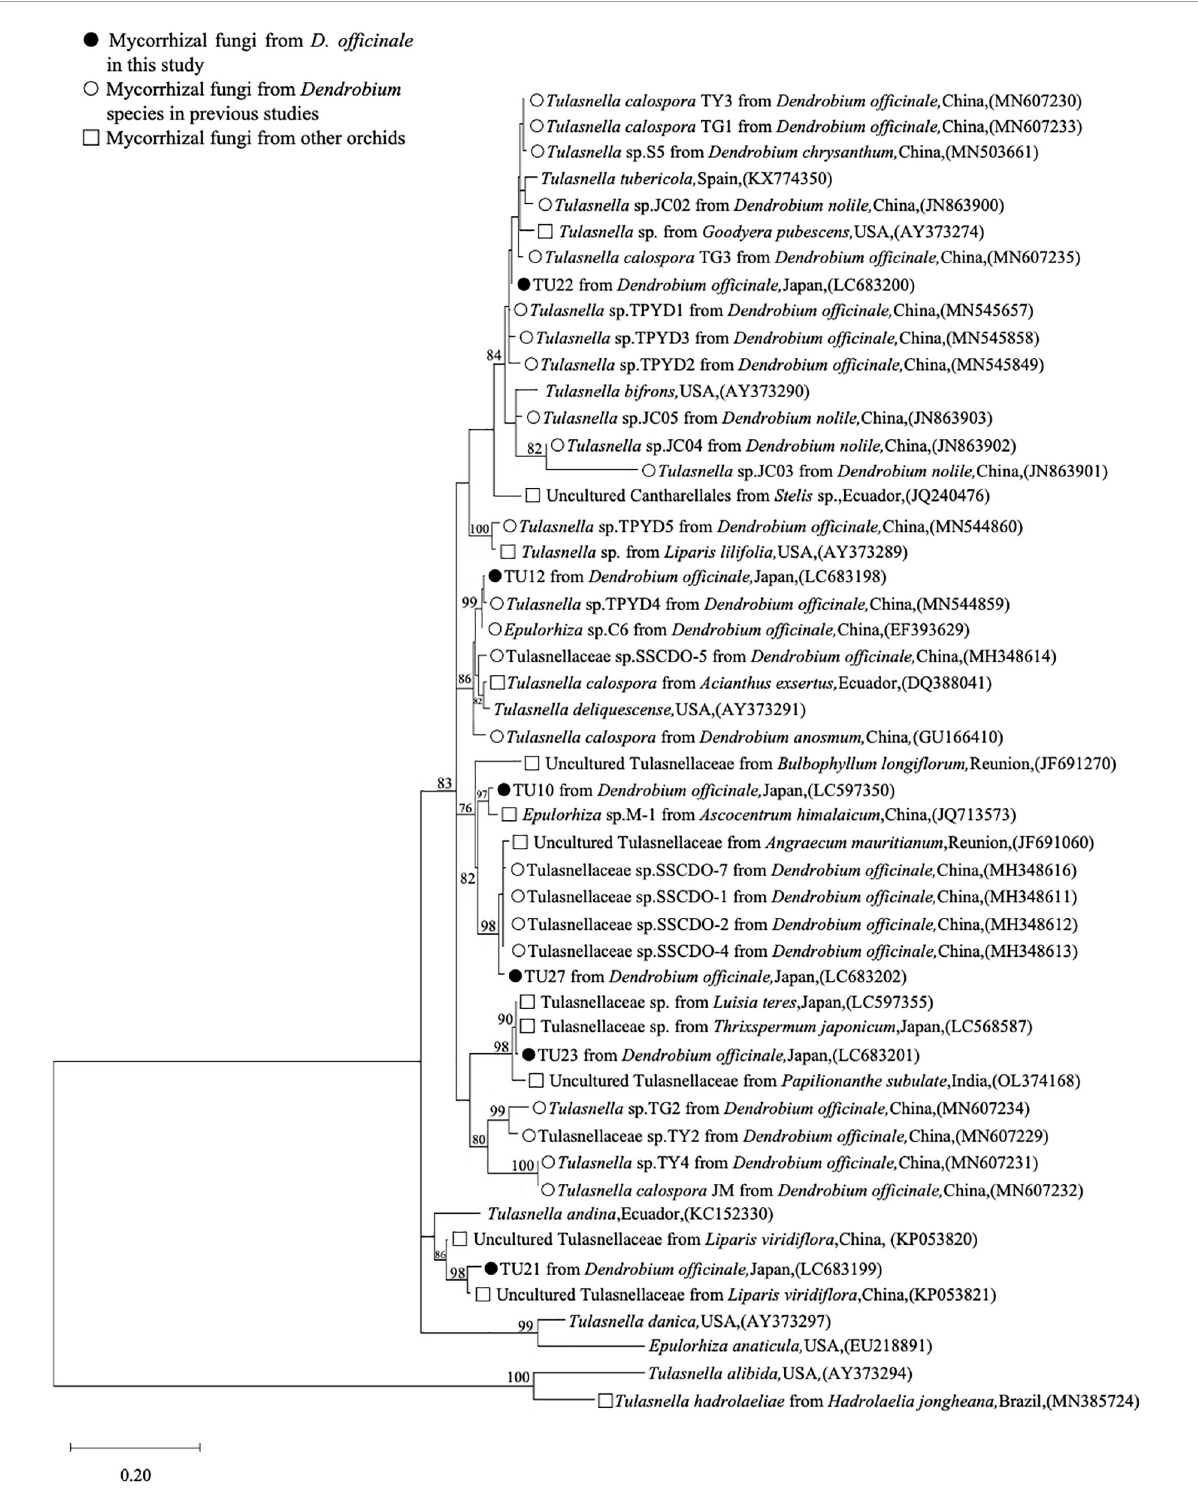
FIGURE5 Maximum likelihood tree for Tulasnellaceae ITS sequences, including six OTUs from this study. Symbols indicate the origin of each sequence. Only bootstrap values ≥ 70% are shown. The tree is drawn to scale, with branch lengths reflecting the number of substitutions per site. Tulasnella alibida and Tulasnella hadrolaeliae were used as outgroup taxa. The 50 assembled sequences were aligned, and the final dataset included 442 bp